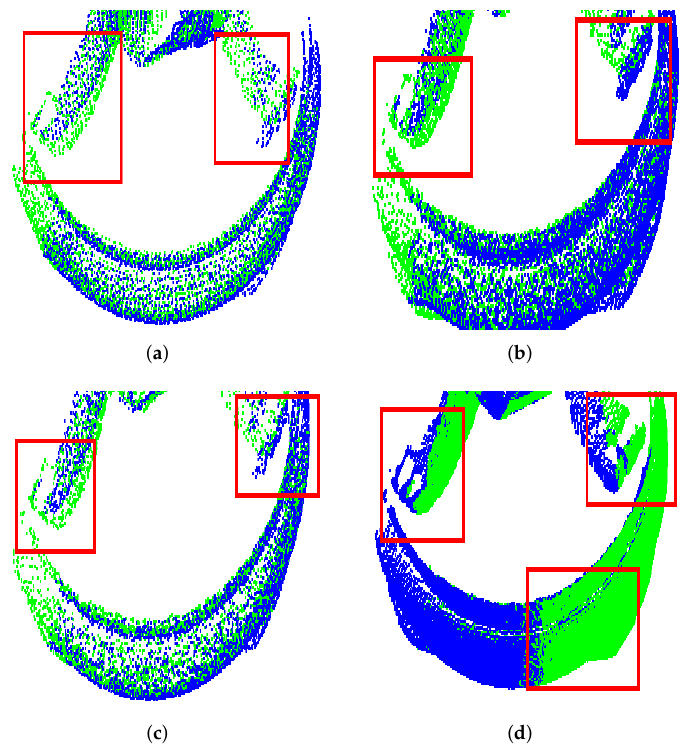
Figure 8. Comparison of the registration results for the Buddha model. ( a ) Uniform. ( b ) Random 50%. ( c ) Random 70%. ( d ) UPS.